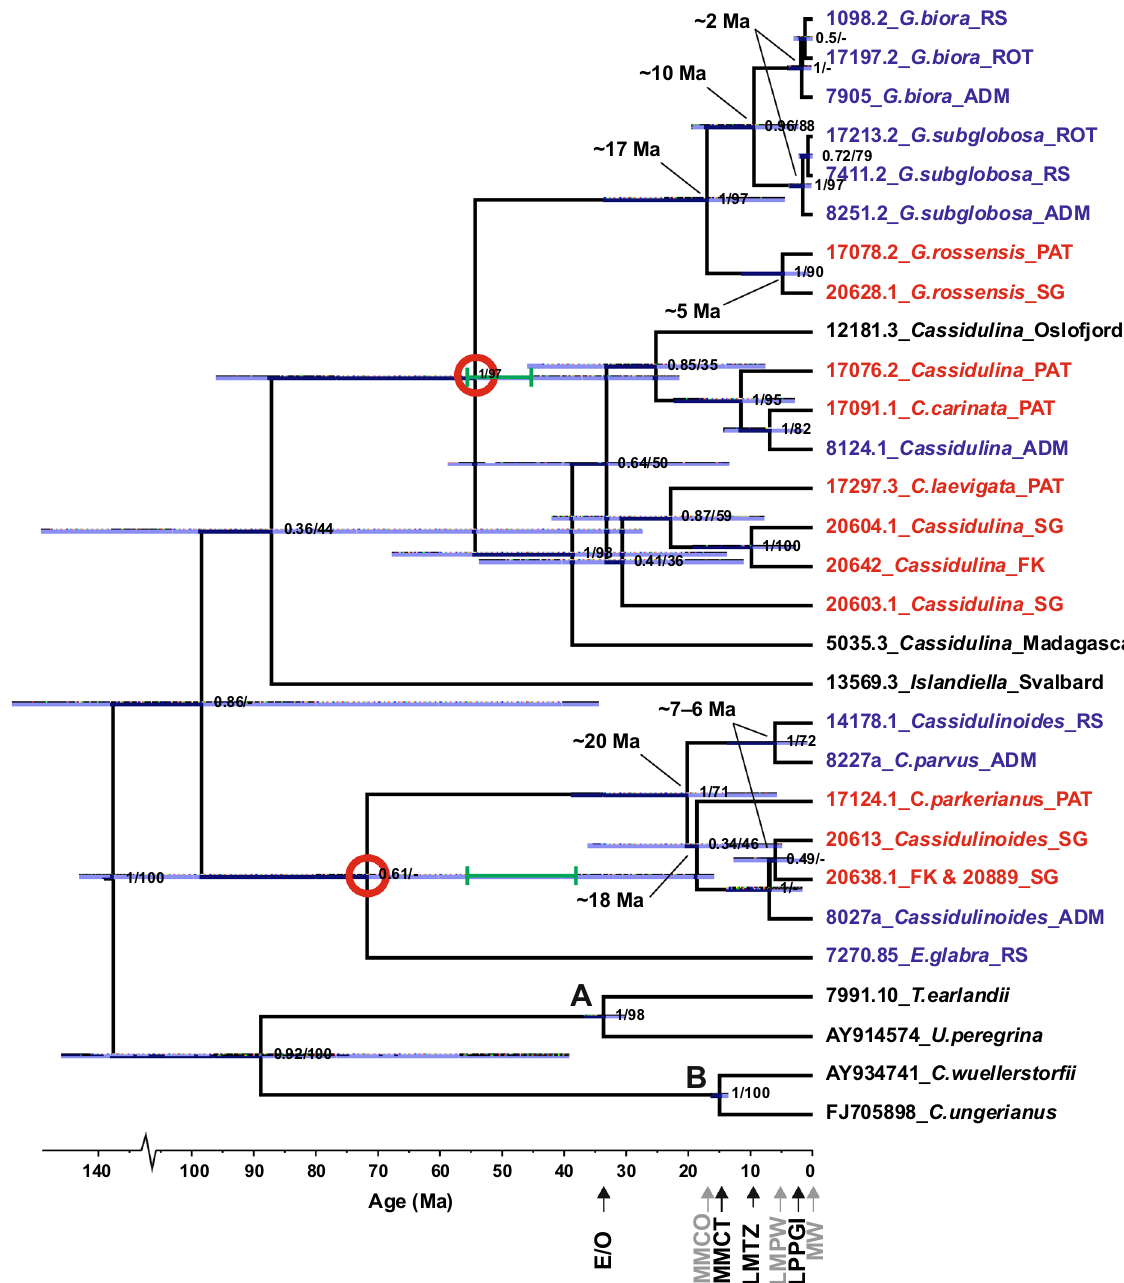
Figure 7. Bayesian time calibrated phylogeny reconstruction using foraminiferal SSU rDNA, showing major divergences in Southern Ocean Cassidulinindae. The posterior probabilities provided above the nodes and supplemented with ML bootstrap values. Sequence ids from Antarctica ( RS Ross Sea, ROT Rothera, Margarite Bay, ADM Admiralty Bay, South Shetlands) are marked in blue, from southern Patagonia ( PAT ), Falkland Islands ( FK ) and South Georgia ( SG ) in green, and other in black. Id of sequences used to calibrate the molecular clock are in black; A and B—calibration points. Red circles show divergence events used for testing of the calibration; green bars show age-ranges for these events suggested by the fossil record. Gray bars on nodes show 95% Highest Posterior Density intervals for discussed divergence events; − not recovered in ML phylogenetic reconstruction shown in Appendix 7. Paleoceanographic events marked on the time scale (warm events in grey): E/O the Eocene/Oligocene cooling, MMCO the mid-Miocene Climatic Optimum, MMCT the Middle Miocene Climate Transition, LMTZ the Late Miocene strengthening of thermal bathymetric zonation, LMPW the Late Miocene to Pliocene warming, LPPGI the Late Pliocene to Pleistocene glacial intensification, MW the modern